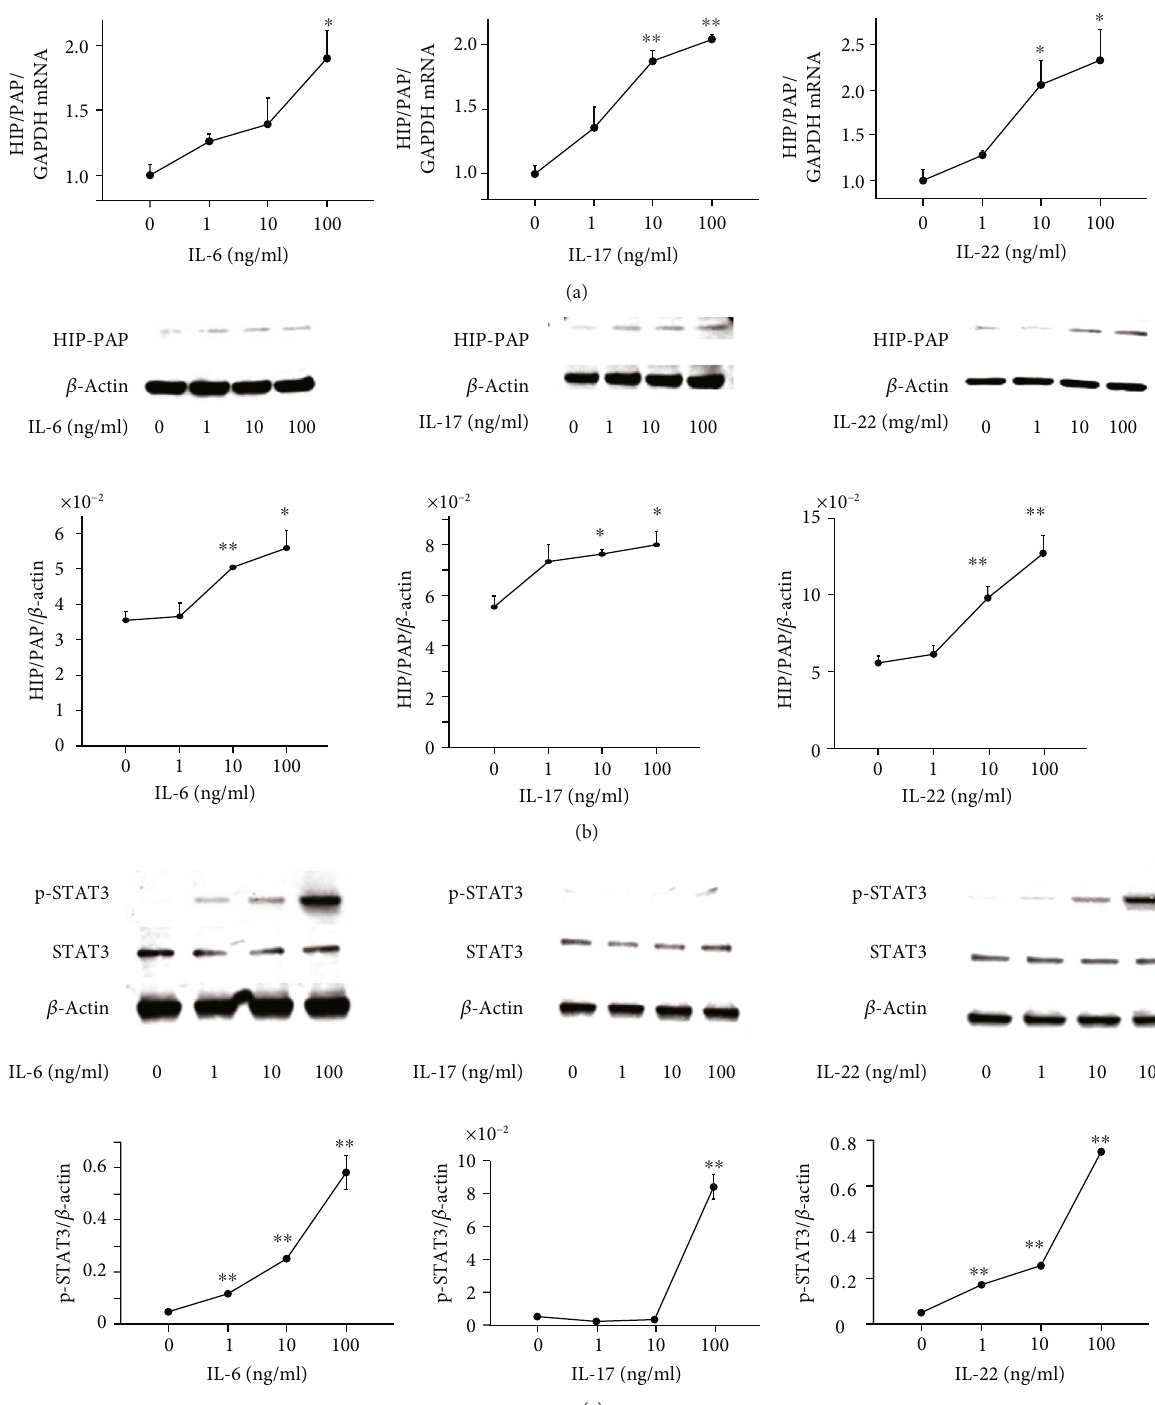
Figure 5: E ff ect of cytokines on the expression of human HIP/PAP in Caco2 cells. (a) Dose-dependent e ff ect of cytokines (IL-6, IL-17, and IL-22) on HIP/PAP mRNA expression in Caco2 cells. Caco2 cells ( 2 × 10 5 ) were cultured in 6-well plates for 24h and then treated with cytokines (IL-6, IL-17, and IL-22) at the indicated concentrations for 24 h. (b) Dose-dependent e ff ects of cytokines (IL-6, IL-17A, and IL-22) on HIP/PAP protein expression in Caco2 cells. (c) Dose-dependent e ff ects of cytokines (IL-6, IL-17, and IL-22) on phosphorylation of STAT3 in Caco2 cells. Caco2 cells ( 2 × 10 5 ) were cultured in 6-well plates for 24 h and then treated with cytokines (IL-6, IL-17, and IL-22) at the indicated concentrations for 30 min. Results are expressed as the mean ± SE . Signi fi cantly greater than in controls at the same time point: ∗ P < 0 : 05 and ∗∗ P < 0 : 01